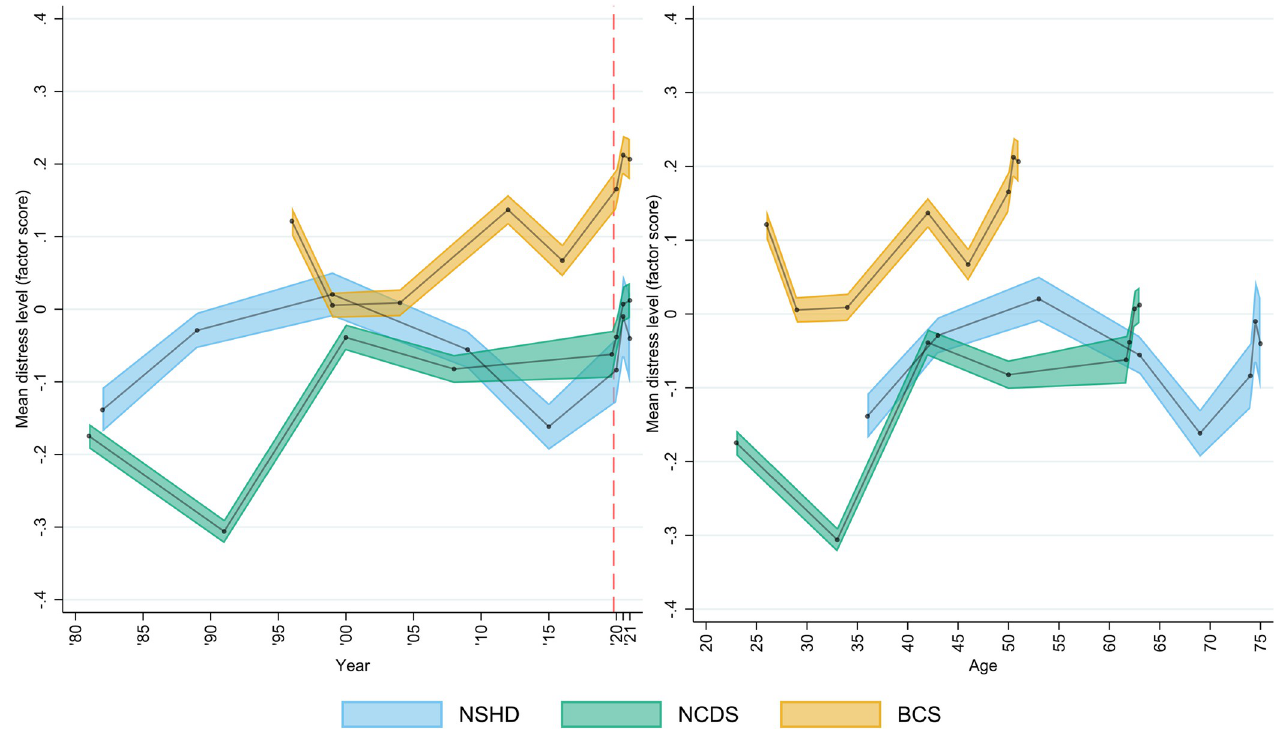
Fig 2. Marginal mean psychological distress cross-cohort factor scores over time (year and age). Unadjusted results. 95% confidence intervals are indicated in lighter shaded areas. BCS70: 1970 British Cohort Study; NCDS: 1958 National Child and Development Study; NSHD: 1946 National Survey of Health and Development. The dashed line represents the first nationwide lockdown enforced in March